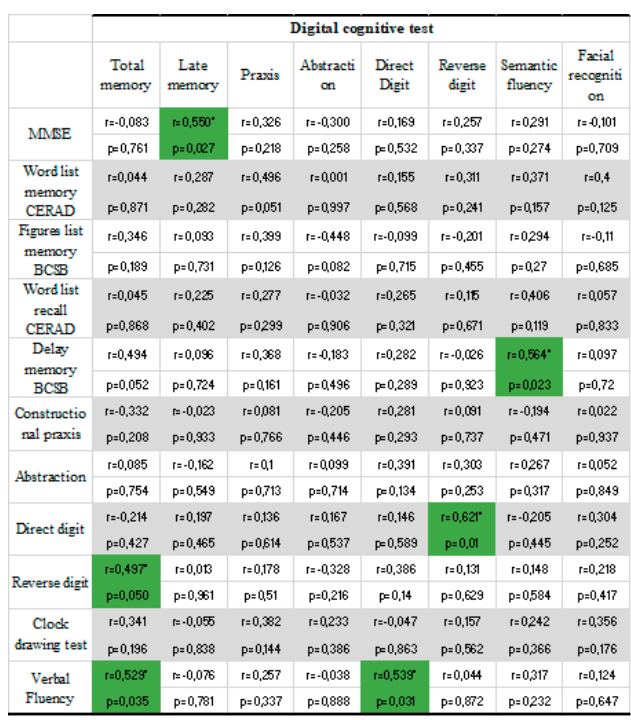
Fig. 7. Statistic convergence analysis of the first